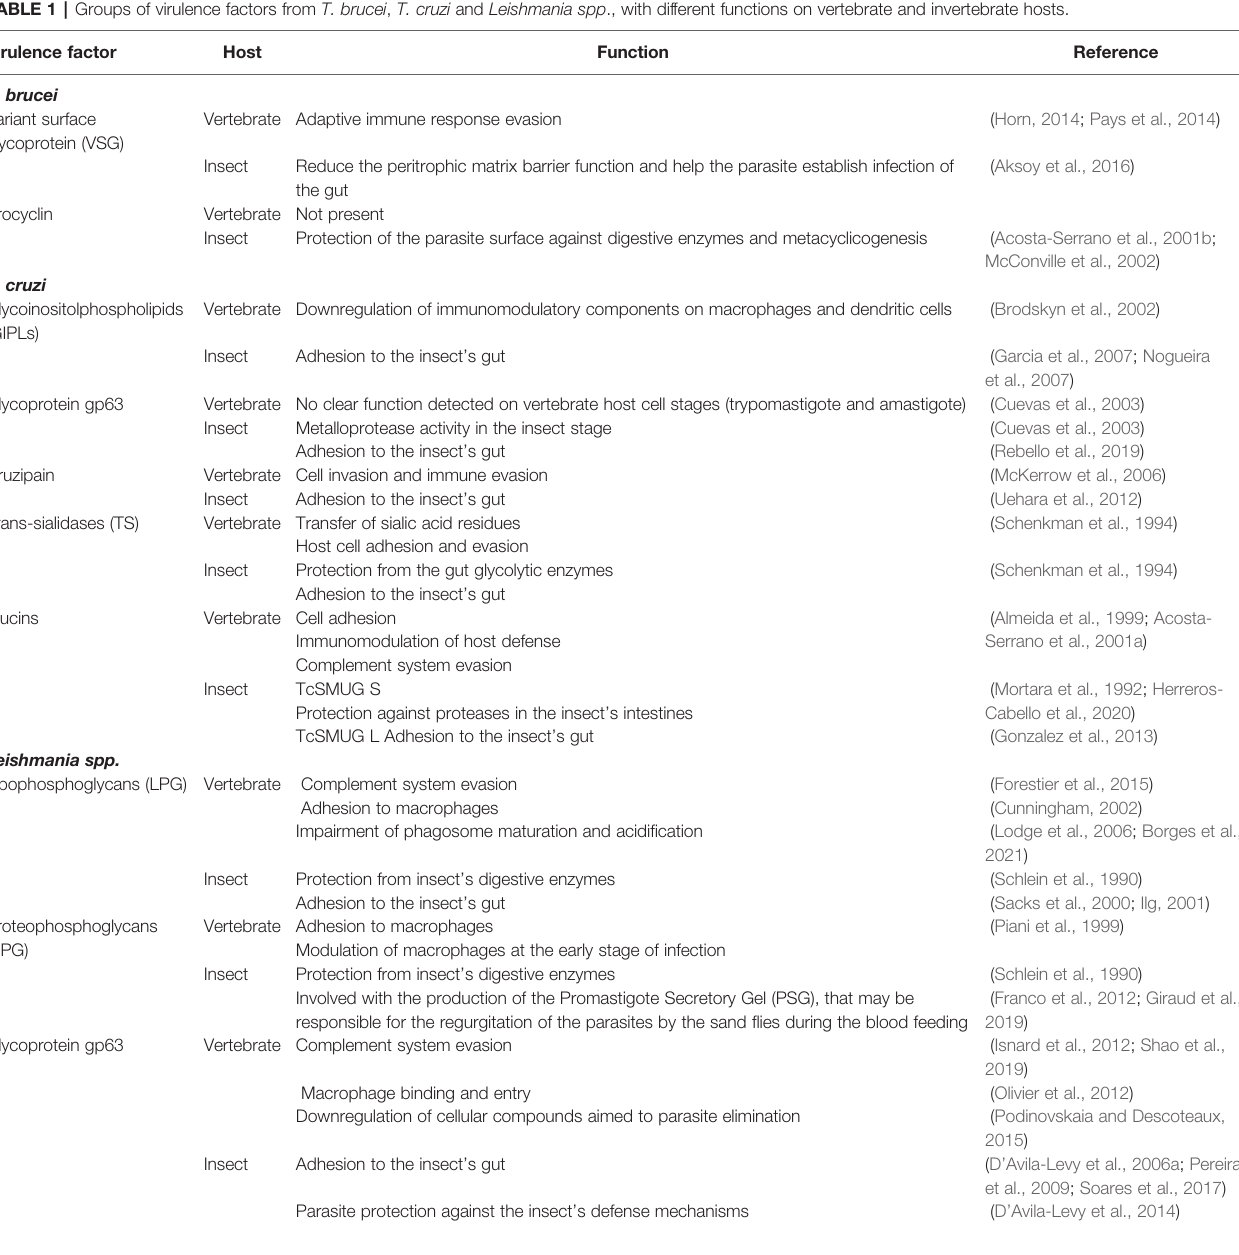
TABLE 1 | Groups of virulence factors from T. brucei , T. cruzi and Leishmania spp ., with different functions on vertebrate and invertebrate